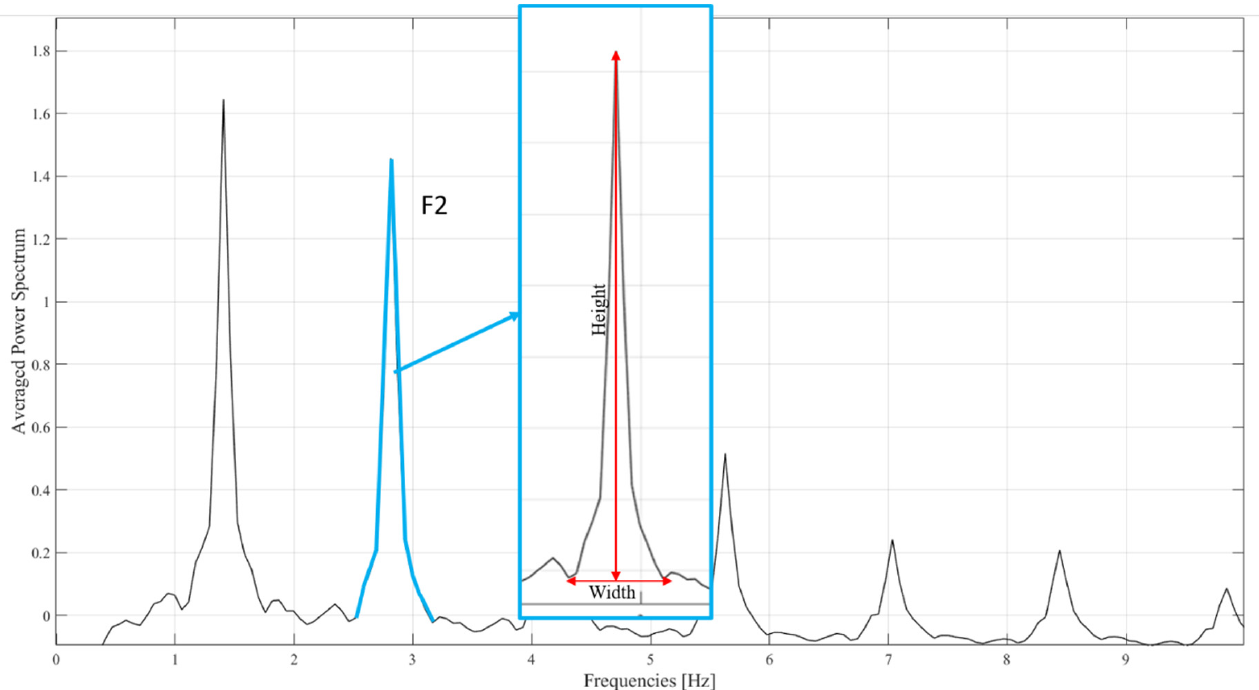
Figure 2. In a representative subject, the Averaged Power Spectrum and the height and width of Frequency 2 (F2), through which the Synchrony Index is calculated.